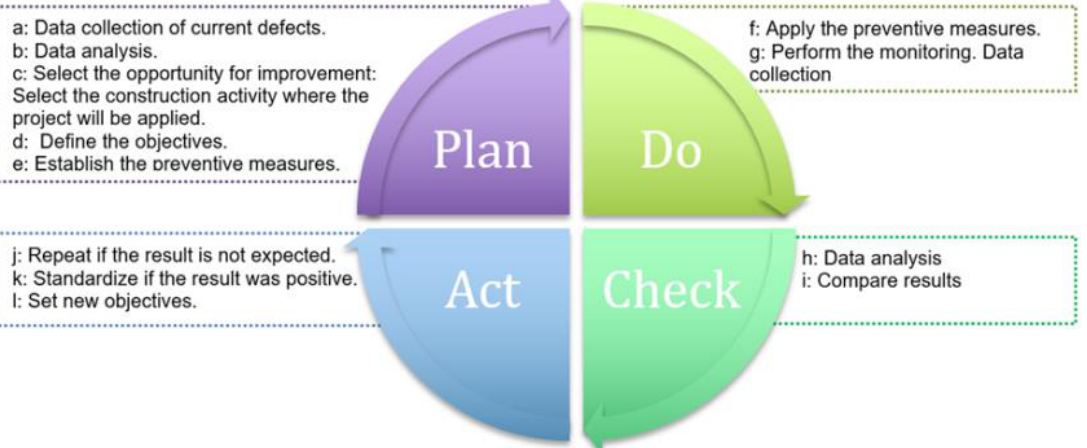
Figure 2. Scheme of the Continuous Improvement Project tasks/activities.